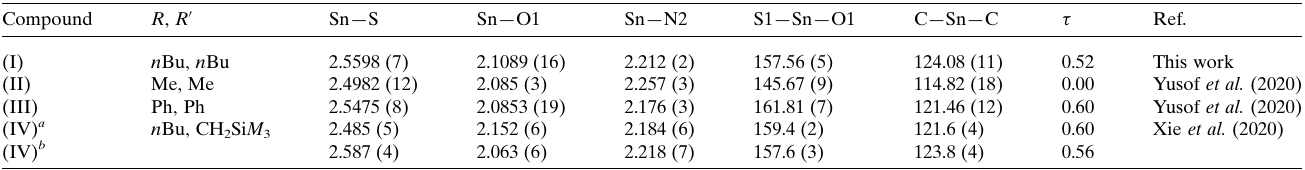
Table 5 A comparison of key geometric parameters (A˚ , (cid:4) ) in structures related to (I). Compound R , R 0